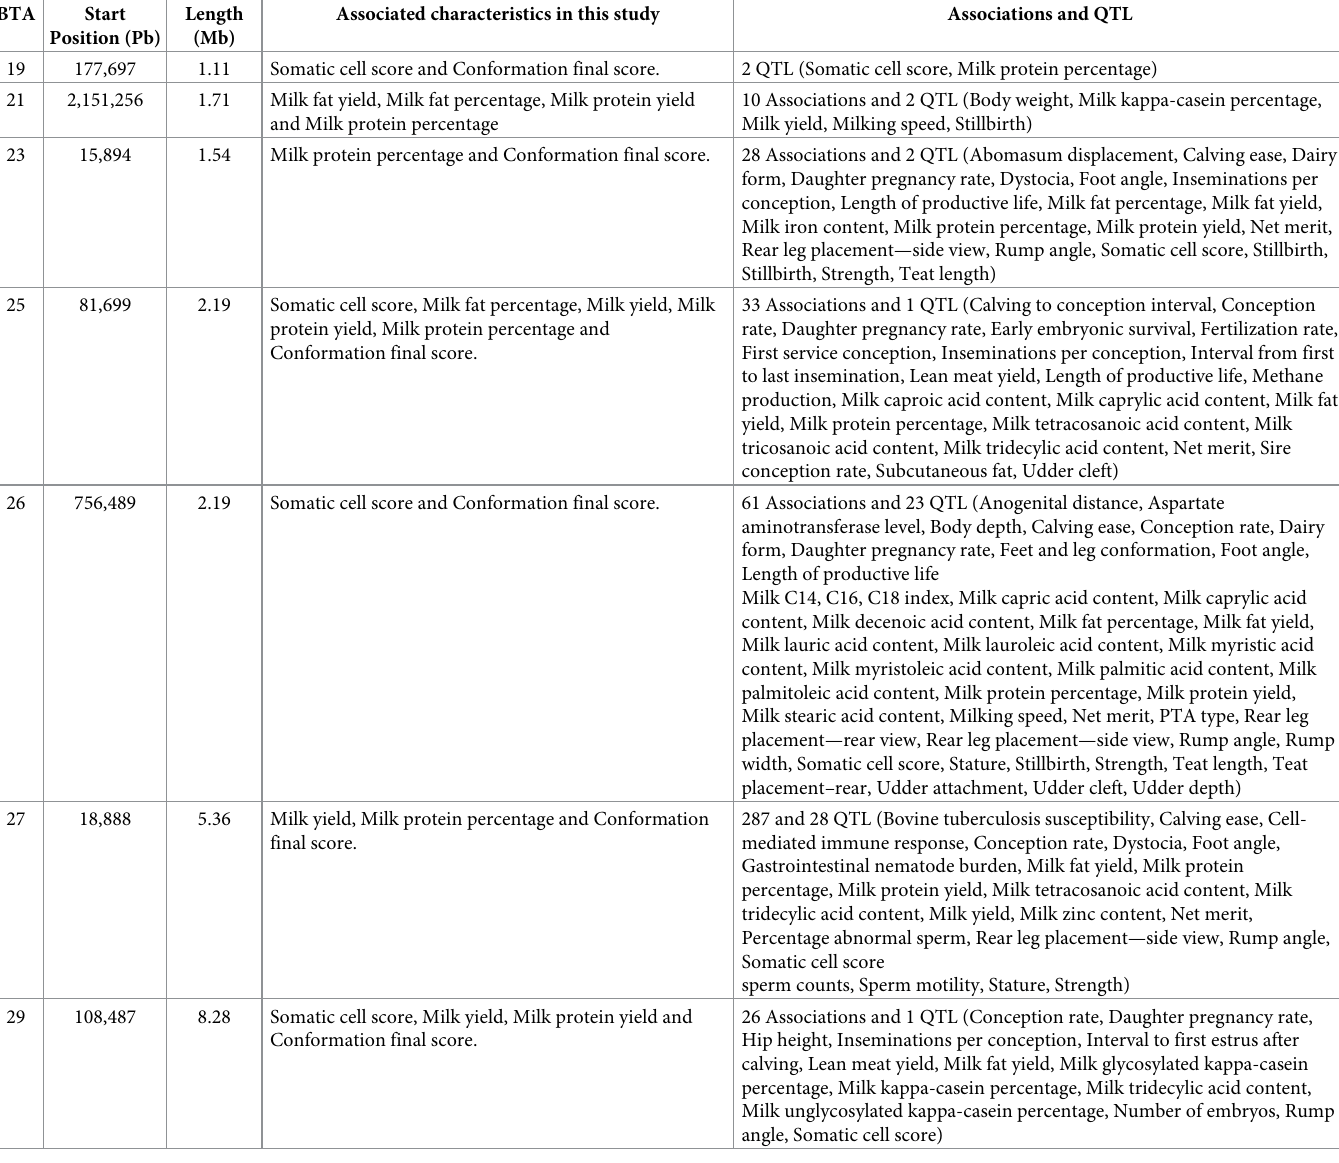
Somatic cell score, Milk yield, Milk protein yield and Conformation final